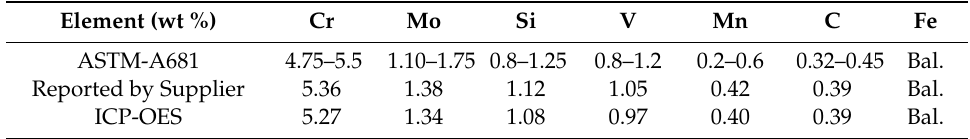
Table 2. Chemical composition of AISI H13 powder.